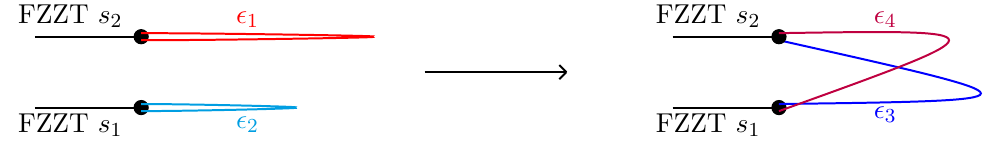
Figure 14 . The 11 ; 22 ! 12 ; 21 long string scattering by